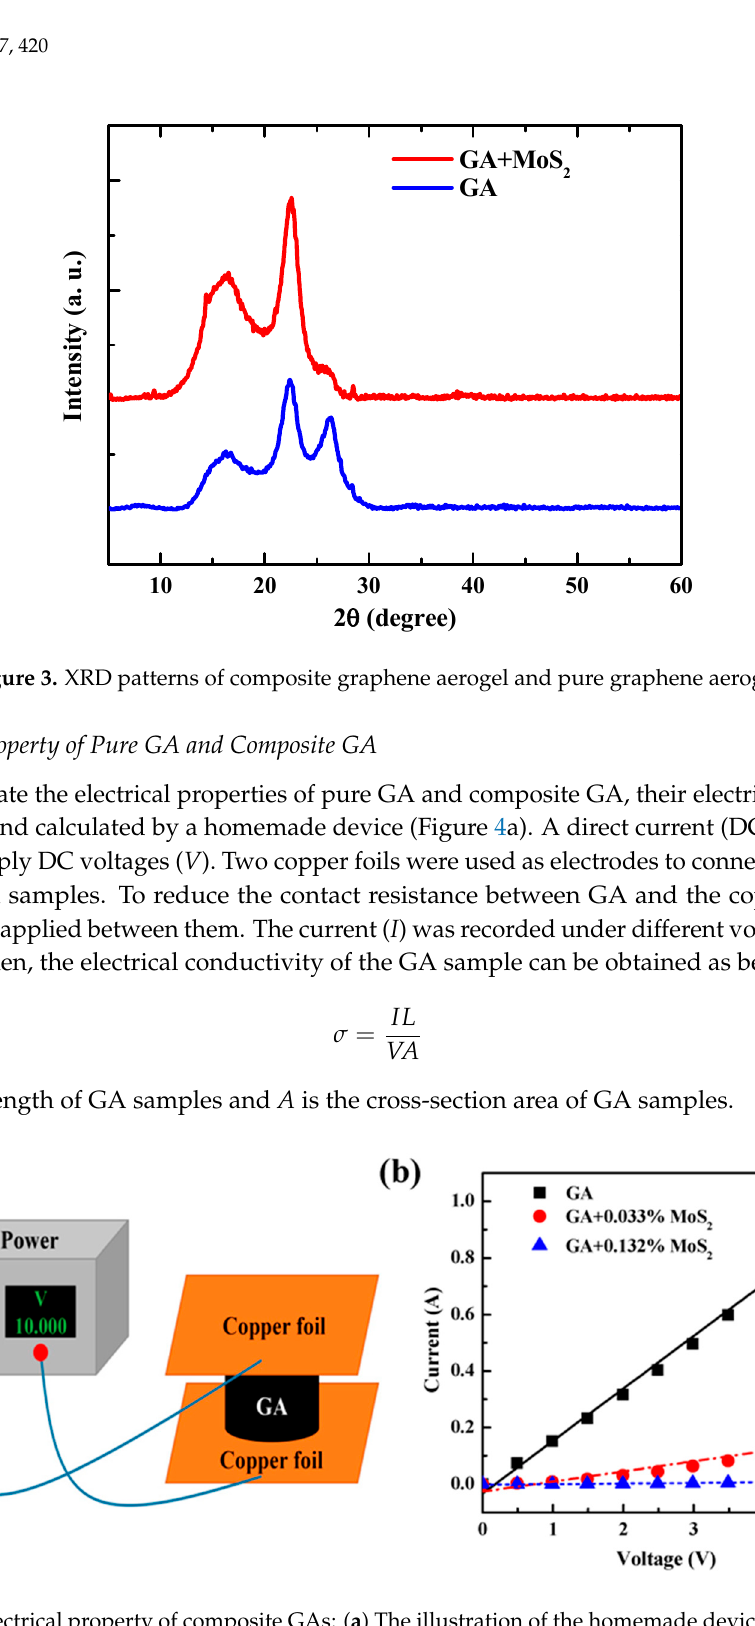
Figure 4. Electrical property of composite GAs: ( a ) The illustration of the homemade device to measure the electrical conductivity of GAs. The DC power can supply DC voltages and measure the current through the circuit. Silver paste was used between the copper electrode and GA sample to reduce the contact resistance. The current through GA samples was recorded under different voltages to obtain the electrical conductivity of the GA sample, as shown in ( b ).